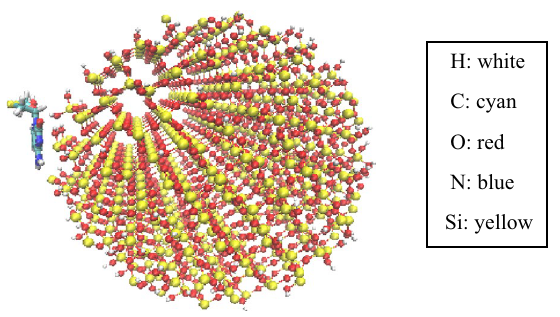
Figure 2. Initial configurations of 3TC on SiO 2 (water box and ions are omitted for better